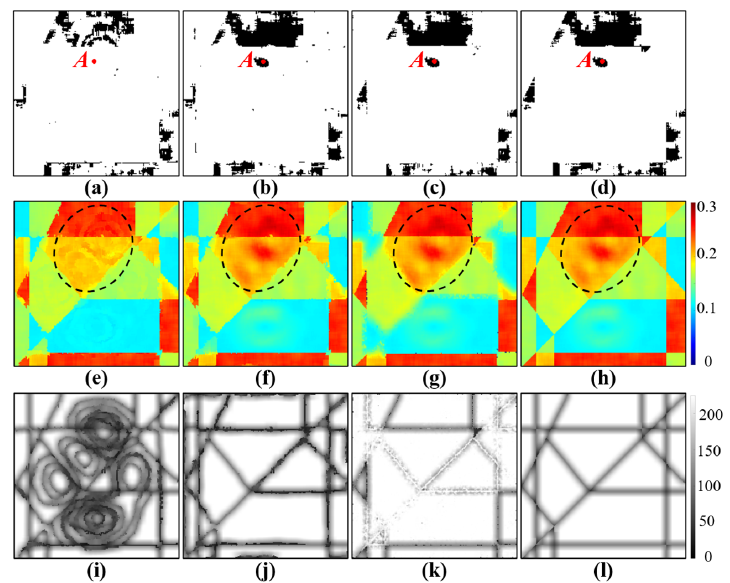
Figure 9. The selected DSs by ( a ) PIHP method with P = 65, β = 9, ( b ) PIHP method with P = 65, β = 0, ( c ) PolHom test, ( d ) ground object type map. The phase quality σ _ φ map by ( e ) PIHP method with P = 65, β = 9, ( f ) PIHP method with P = 65, β = 0, ( g ) PolHom test, ( h ) ground object type map. The number of homogeneous neighbors per pixel by ( i ) PIHP method with P = 65, β = 9, ( j ) PIHP method with P = 65, β = 0, ( k ) PolHom test, ( l ) ground object type map. Figure 10 shows the homogeneous neighbors of pixel (58,99) with simulated interfero- gram base map and the corresponding σ ϕ . It can be seen that PIHP fits the interferometric phase distribution best and σ ϕ = 0.2044 of PIHP indicates the highest phase quality.